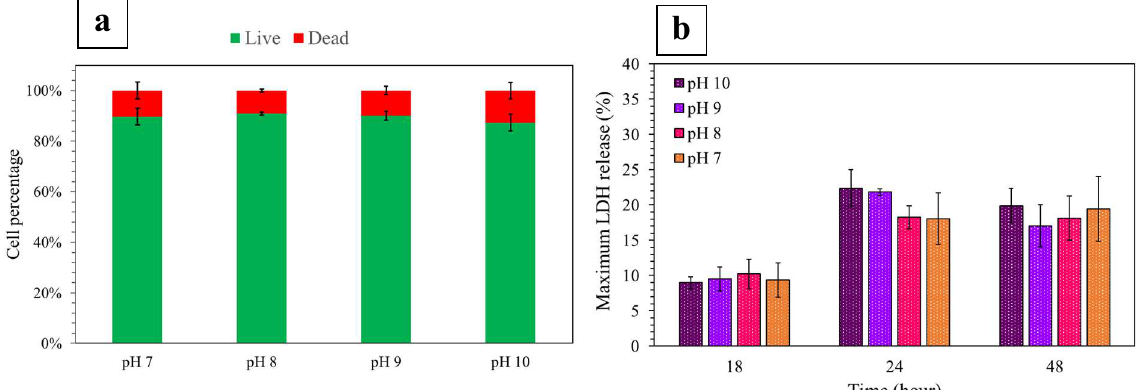
Figure 5. Cell viability assessment of NIH/3T3 fibroblast-seeded GAE-densified collagen gels of various pH: ( a ) Viability and mortality percentages, and ( b ) release of LDH from seeded